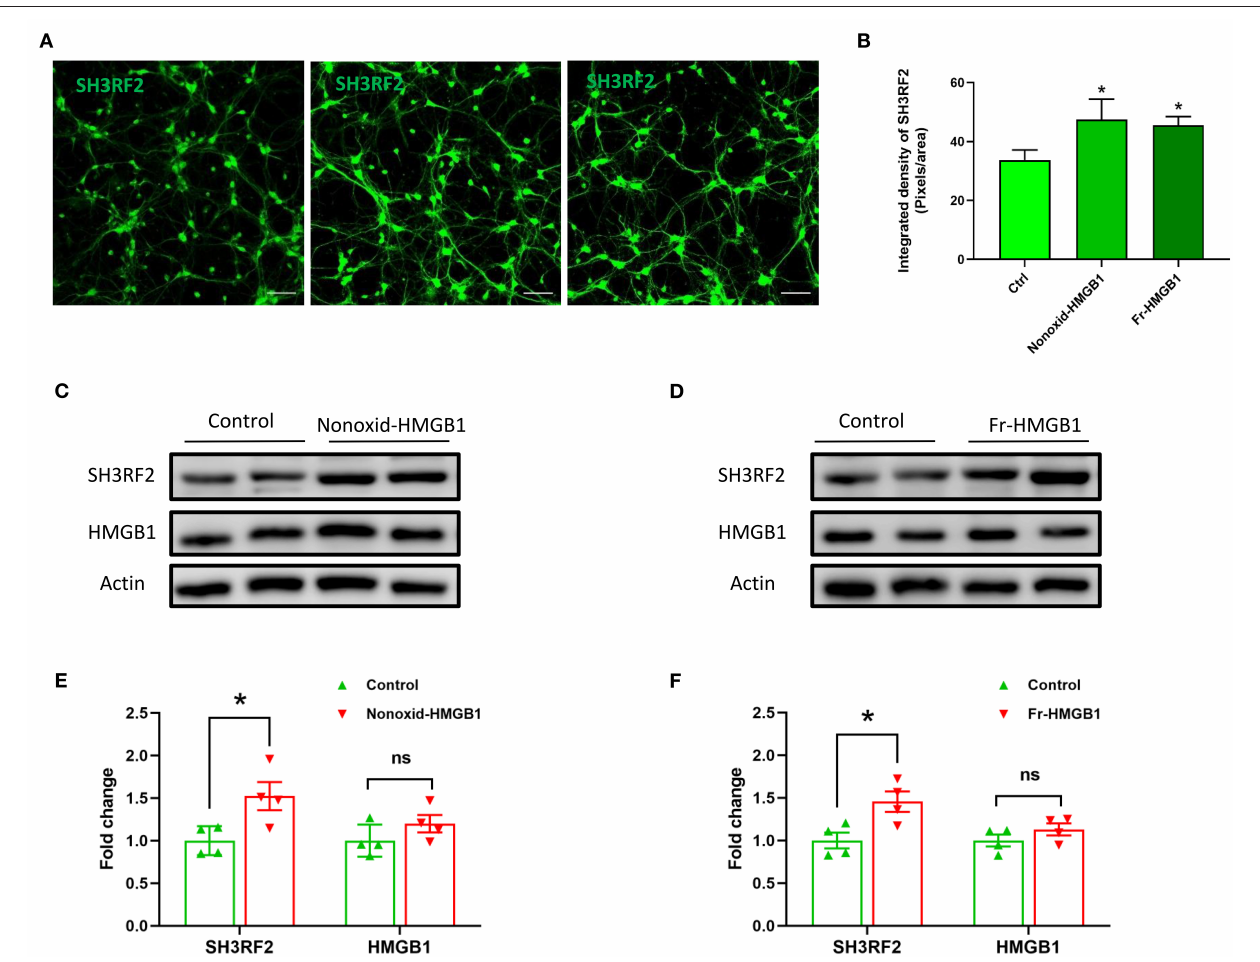
FIGURE 3 | Validation and expression analysis of SH3RF2 in neurons after being treated with nonoxid-HMGB1 or fr-HMGB1. (A) Representative fluorescence images of neurons. Scale bars, 50 um. (B) Relative quantification of the fluorescence signal. (C–F) Western blot for SH3RF2 and HMGB1. Mean ± SEM, * p <